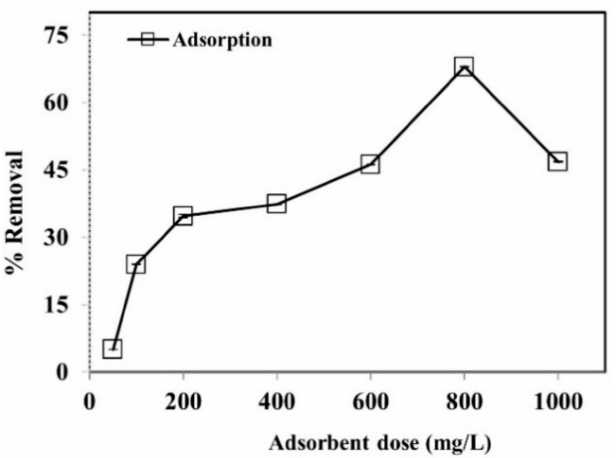
Figure 7. The effect of adsorbent dosage on phenol removal using adsorption process. Experimental conditions: phenol conc. = 25 mg L − 1 , pH = 3.5, temperature = 30 ± 2 ◦ C, time = 60